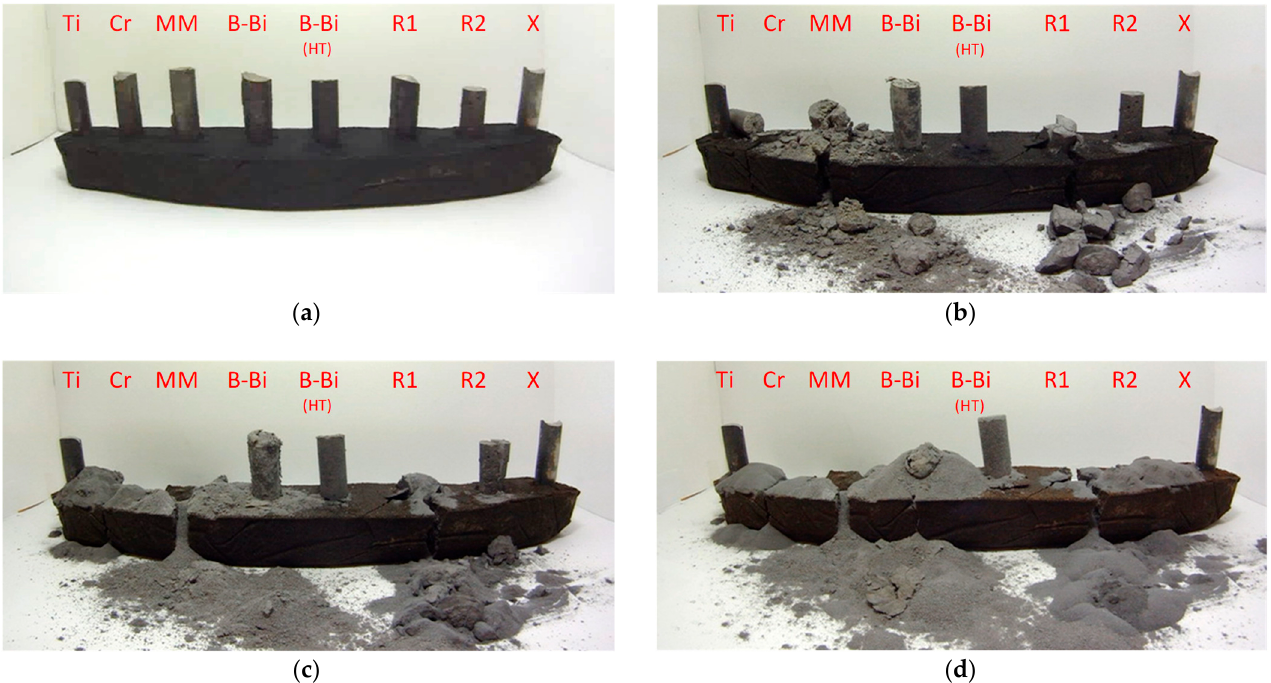
Figure 15. Cast samples of high-aluminum cast iron with addition of Ti—titanium, Cr—chromium, MM—rare earth elements, B–Bi—boron and bismuth, B–Bi (HT)—boron and bismuth after heat treatment, R1—reference sample (standard cooling rate), R2—reference sample (increased cooling rate) and X—know-how (an attempt will be made to implement into production); observation time: first day ( a ), 74 day ( b ), 148 day ( c ), 216 day ( d ).